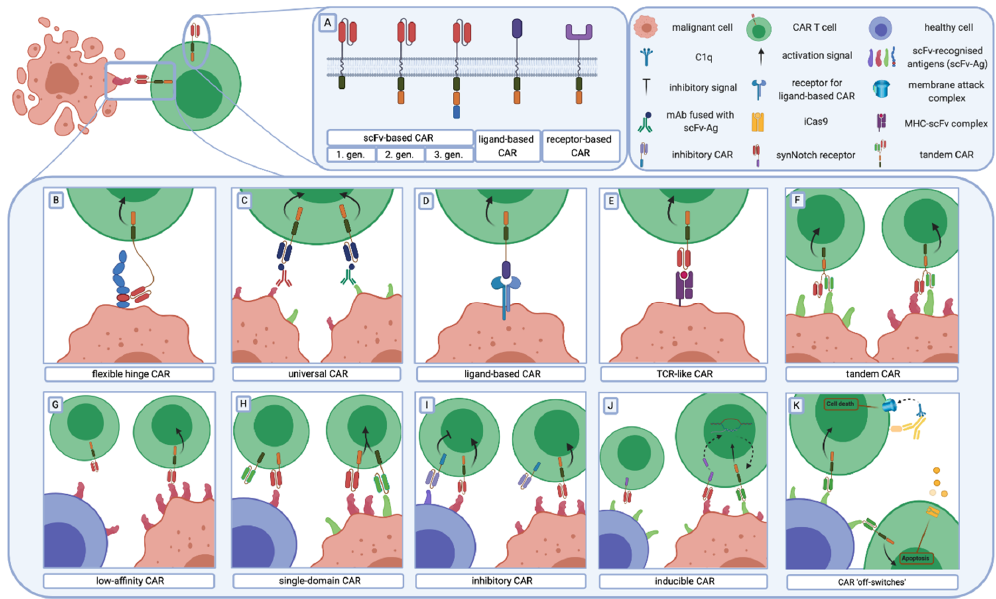
Figure 1. The CAR structure and general strategies to enhance CAR-T cell therapy. ( A ) Three generations of chimeric antigen receptors are based on the composition of the intracellular part. First-generation CARs contain one stimulation domain, whereas second and third generations have one or two additional costimulatory domains, respectively. Besides scFv, other molecules (ligands or receptors) are used as antigen recognition domains. ( B–F ) Strategies to increase CAR-T cell efficacy and selectivity against tumour cells. ( B ) Epitopes, located adjacent to the cell membrane, require a longer and more flexible hinge than those easily accessible for CARs. ( C ) In universal CARs, by targeting an epitope fused with an antibody, specificity relies mostly on antibody selectivity. ( D ) The use of a ligand instead of scFv as an antigen recognition domain could increase the specificity of CAR-T cells. ( E ) TCR-like CAR-T cells target intracellular cancer-specific antigens that are presented by MHC. ( F ) Tandem CARs are designed to target more than one antigen simultaneously. They recognise two different antigens and provide effective lysis of malignant cells expressing one or both cognate antigens. ( G–K ) Strategies to decrease on-target off-tumour toxicity and the probability of healthy cells lysis. ( G ) Decreased affinity toward cognate antigen enables CAR-T cells to distinguish healthy cells with a low expression level of TAAs from malignant cells with a high level of TAAs. ( H ) The division of the full activation signal to two independent CARs with different antigen specificities restrict the CAR-T cell’s cytotoxicity to malignant cells that express both targeted antigens while sparing healthy cells with only one antigen on their surface. ( I ) Additional co-modification of CAR-T cells with iCAR enables specific recognition of non-malignant cells and inhibition of toxicity against them. ( J ) The expression of the “effector” CAR is regulated by the synNotch receptor redirected against another TAA. ( K ) CAR “off-switches” are based on the co-modification of CAR-T cells with antibody-recognised molecules or with iCas9. This enables selective CAR-T cell clearance while CAR-related life-threatening side effects occur. Abbreviations: CAR—chimeric antigen receptor, scFv—